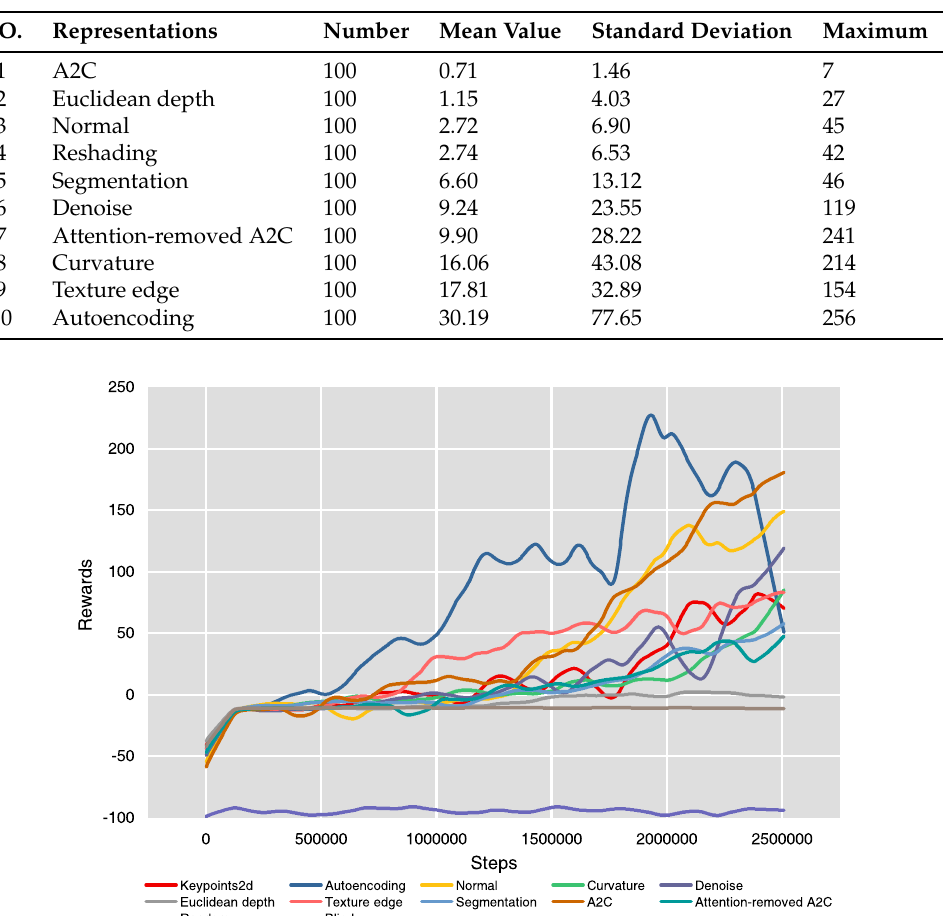
Figure 5. Reward curves. Rewards obtained by agents with different state representations in the policy learning